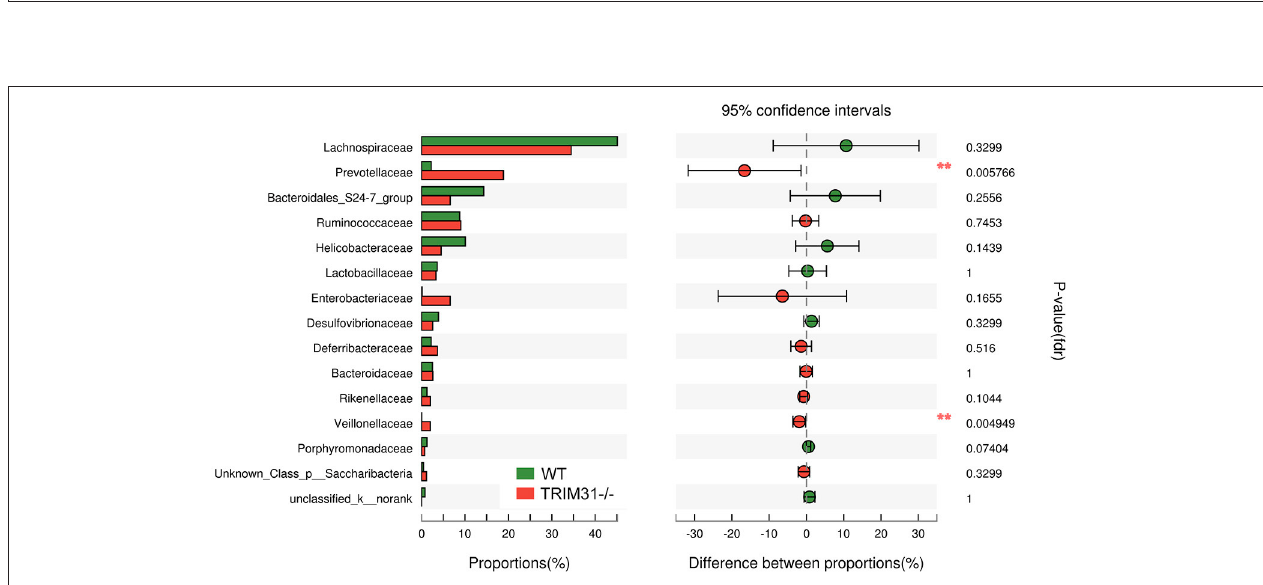
FIGURE 4 | Significantly different phylotypes between TRIM31 − / − and WT mice at the family level. Data for mice are shown as relative abundance (%) of families in each group. n = 7, in each group. ** P < 0.01, TRIM31 − / − vs. WT mice by Mann-Whitney U -test.